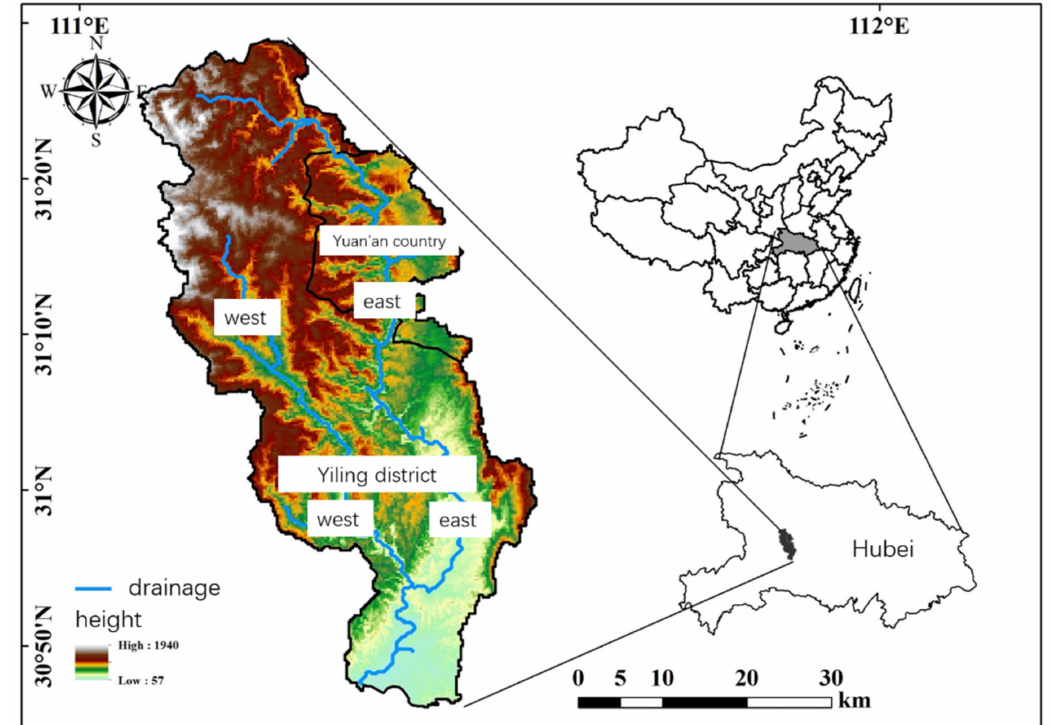
Figure 3. The drainage map of Huangbai River